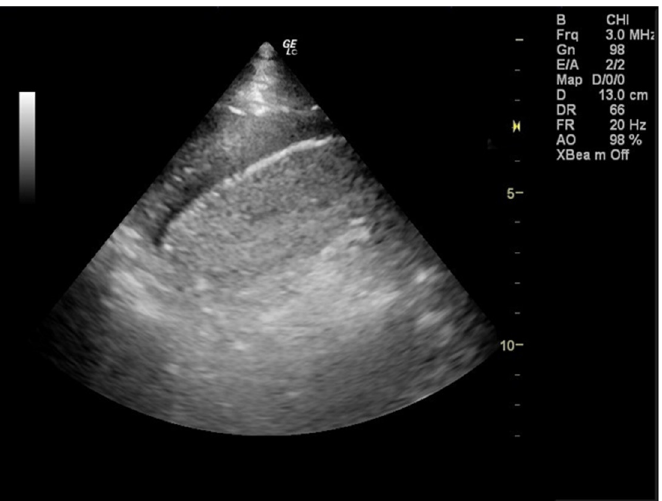
Figure 1. During the focused lung ultrasound a small left pleural effusion was detected by placing the transducer in the left posterior axillary line at the lower part of the chest (zone L3).